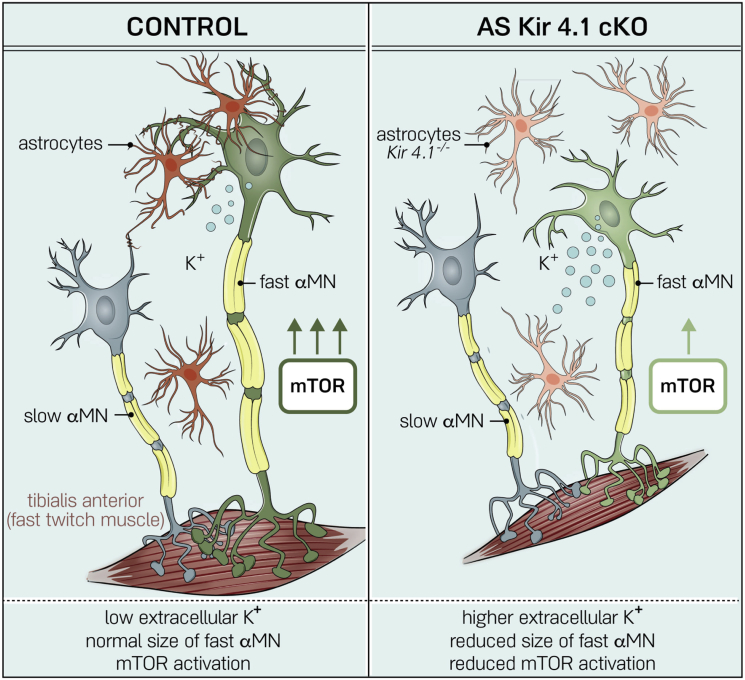
AS-Encoded Kir4.1 Is Required for FαMN Function and Peak Force GenerationAS Kir4.1 deletion leads to decreased FαMN size with mTOR downregulation, loss of fast-firing MN frequency, and decrease in fast-twitch muscle fiber size and peak strength without affecting MN survival.